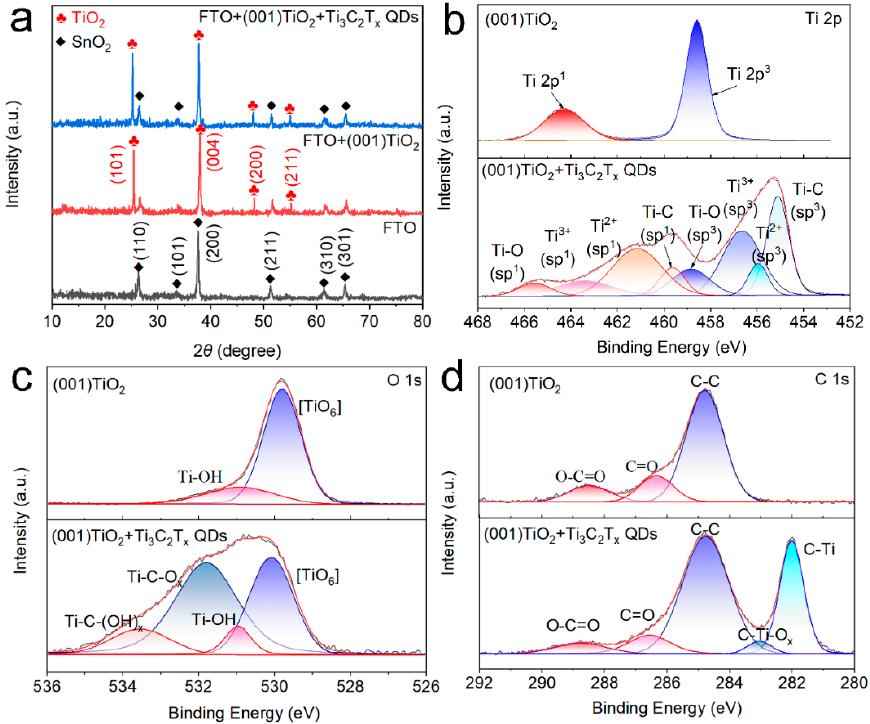
Figure 3. ( a ) X-ray diffraction (XRD) pattern of FTO glass, (001) TiO 2 and Ti 3 C 2 T x QDs/(001) TiO 2 and X-ray photoelectron spectroscopy (XPS) results of ( b ) Ti 2p, ( c ) O 1s, and ( d ) C 1s orbital of (001) TiO 2 and Ti 3 C 2 T x QDs/(001) TiO 2.